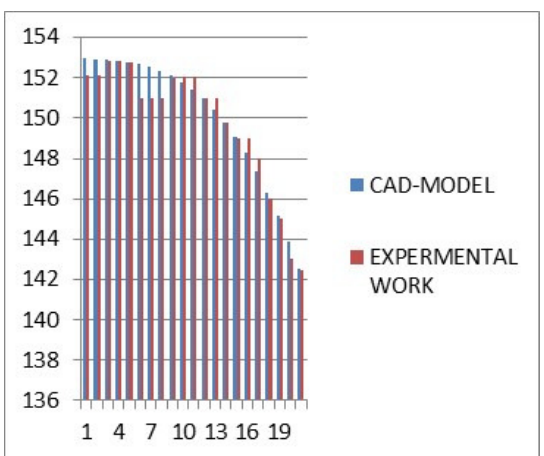
Fig. 9. The compression and difference values in dimensions between the proposed and original part for X-axis.